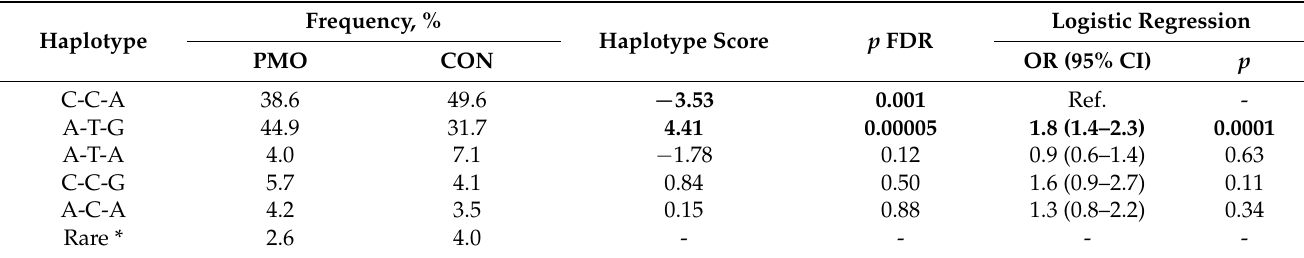
Table 3. Haplotype analysis of VDR rs7975232, rs1544410, and rs731236 gene variants in patients with postmenopausal osteoporosis (PMO) and control (CON)